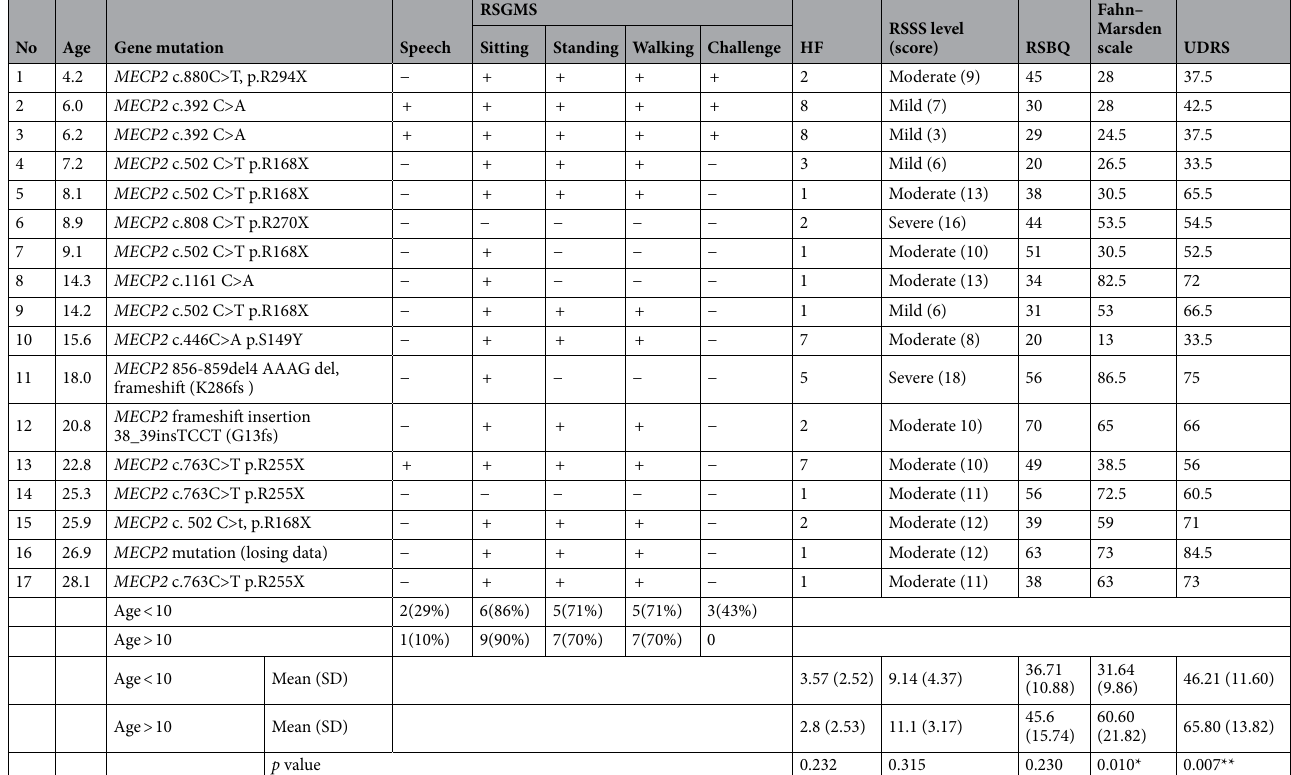
Table 1. Demographic and clinical features of patients with Rett Syndrome. Age group < 10 years (n = 7), > 10 years (n = 10); Speech +: single word, −: mute. MECP2 methyl-CpG-binding protein 2, RSGMS multiple comparison with Benjamini–Hochberg correction.